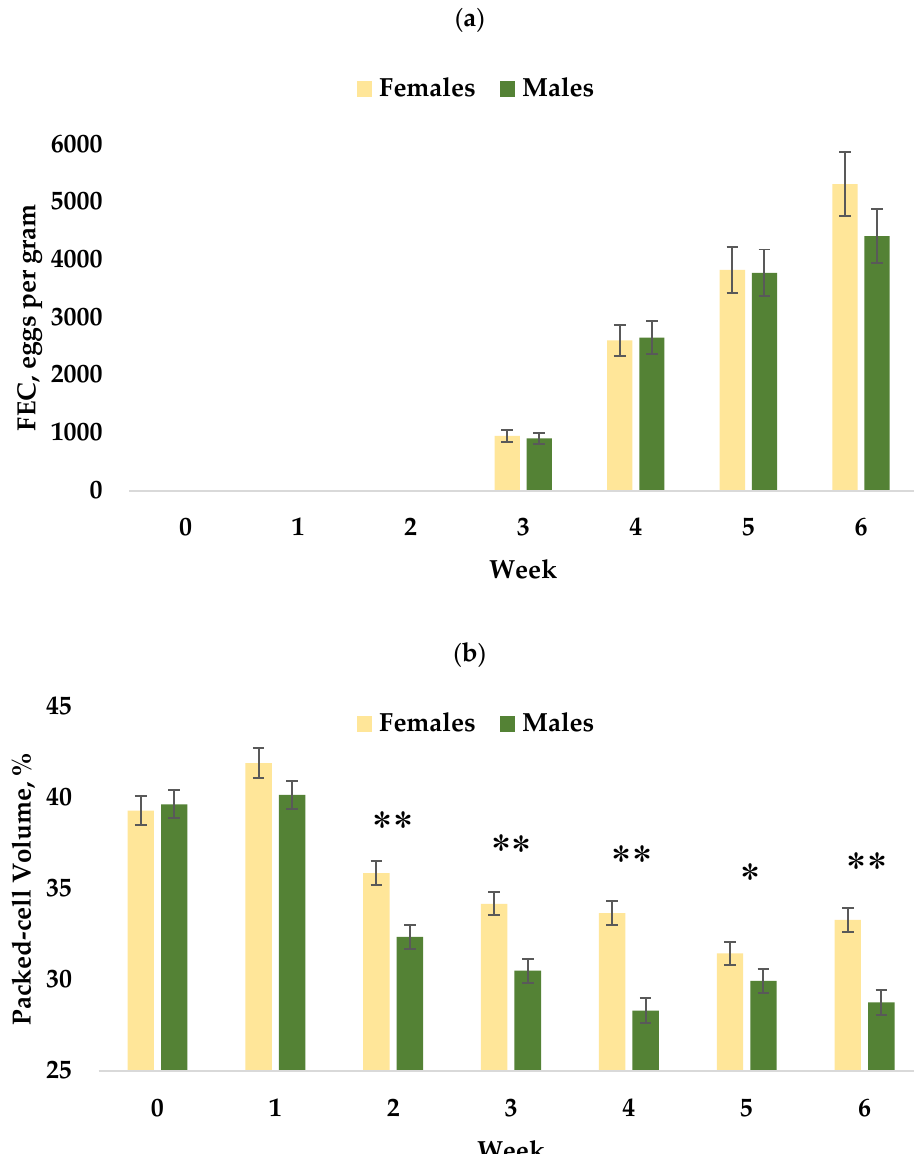
Figure 3. Differing responses to H. contortus infection between female and male Rambouillet lambs. ( a ) Fecal egg count by sex. Female lambs tended to have higher FEC at week six ( p = 0.0562). ( b ) Mean packed-cell volume % (PCV) for lambs by sex. Female lambs appeared to be more “resilient” to H. contortus infection than males, as evidenced by the greater reduction in PCV of male lambs. For all lambs, H. contortus larvae had begun feeding on host blood by week two, however FEC were not above zero until week three, confirming that larvae begin consuming host blood prior to sexual maturity.